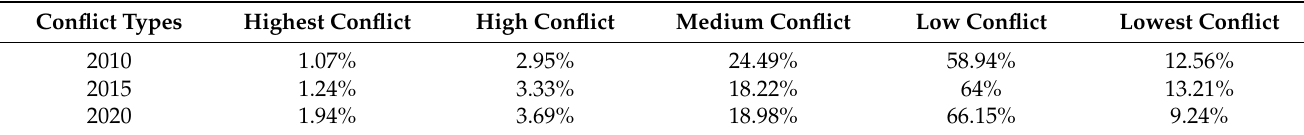
Table 3. Area composition of different conflict types.